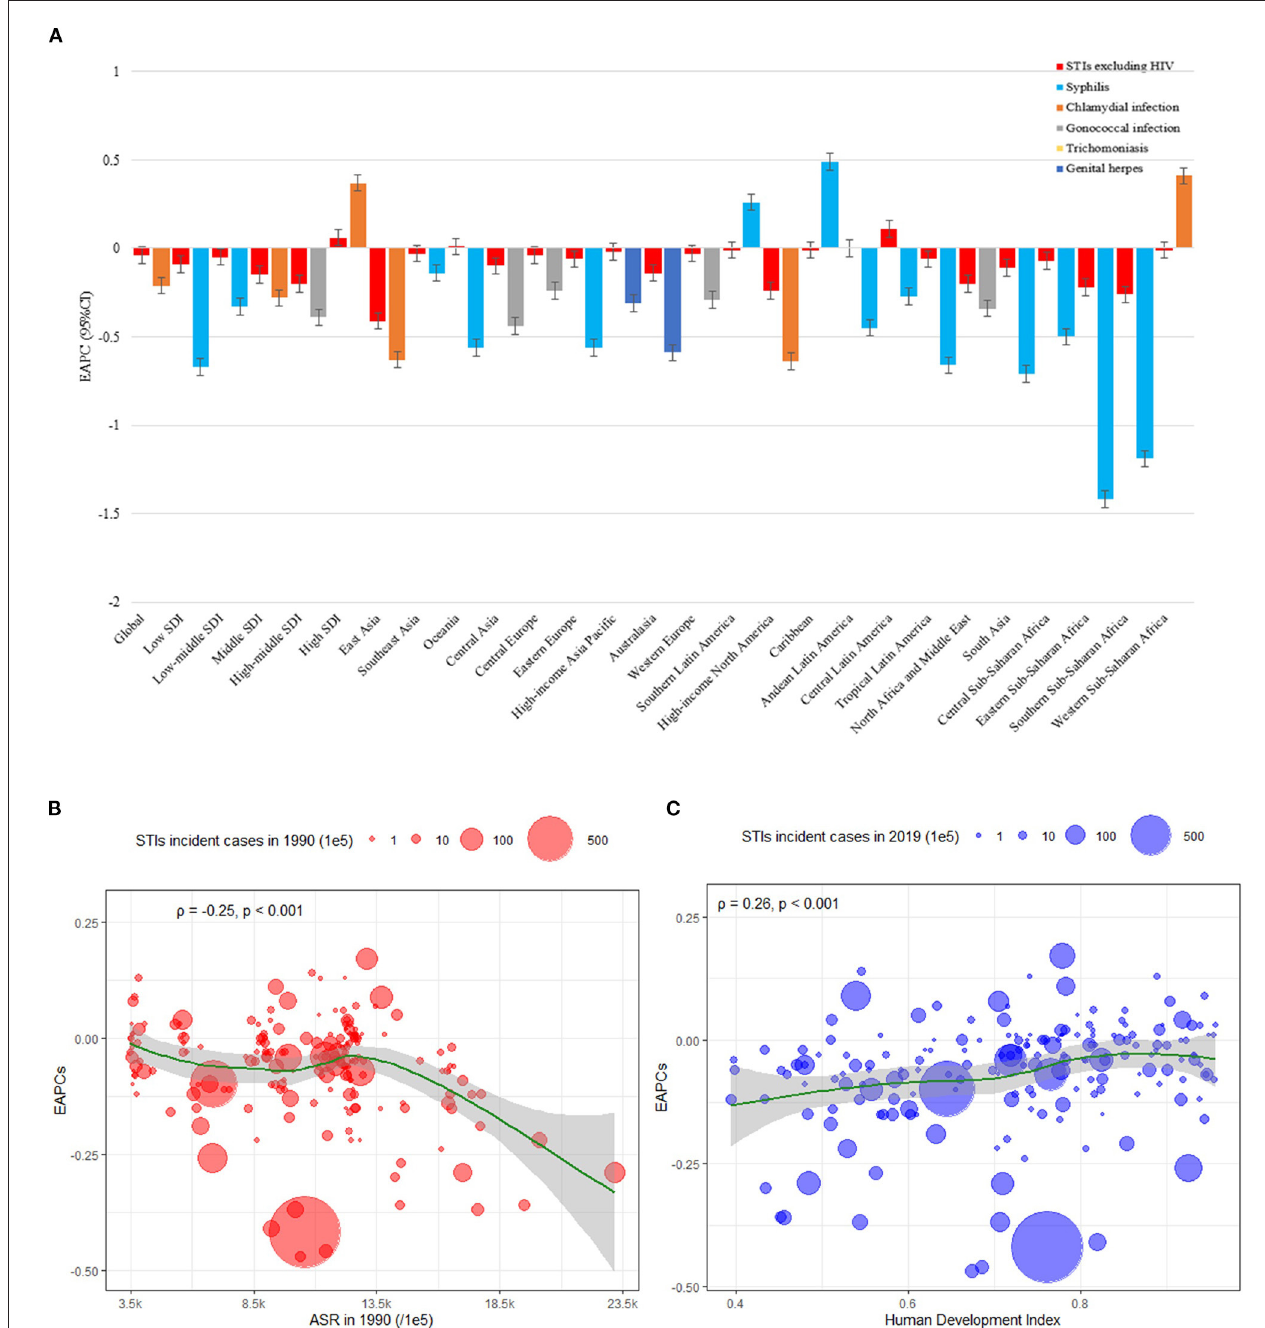
FIGURE 5 | EAPCs in STI ASR excluding HIV from 1990 to 2019, at global, regional, and national levels. (A) EAPC in STI ASR from 1990 to 2019, by pathogenic microorganism and by region. EAPC in each region are presented as an overall and an absolute maximum caused by pathogenic microorganism. The correlation between EAPC and (B) STI ASR in 1990 and (C) HDI in 2019. The circles represent countries with available HDI data. Circle size represents total number of STI cases. The ρ indices and p values presented in (B) and (C) were derived from Pearson correlation analysis ASR, age-standardized rate; EAPC, estimated annual percentage change; HDI, human development index; STIs, sexually transmitted infections; HIV, human immunodeficiency virus.